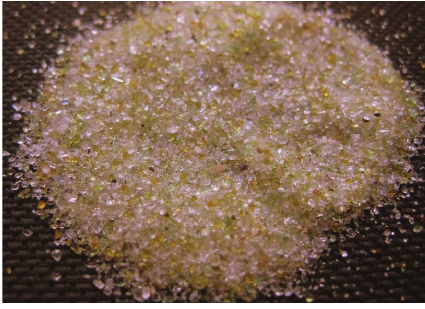
Figure 3: Ground tire gradation curve.